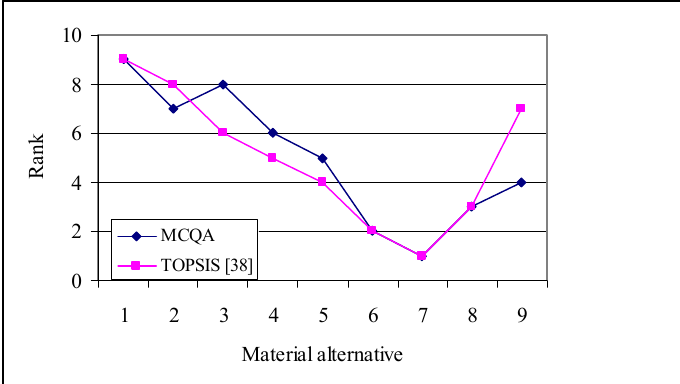
Fig. 1. Comparison of material rankings for example 1